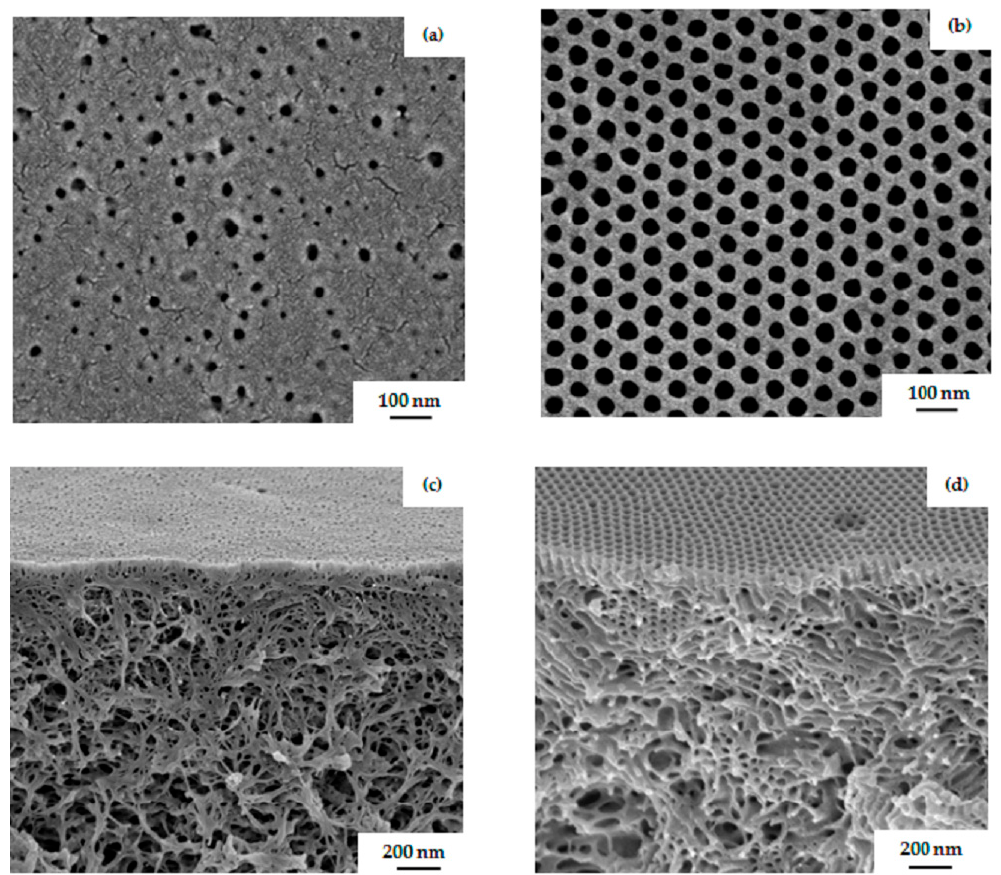
Figure 9. SEM topography images of membranes prepared from ( a ) 23 wt % PS 76 -PSMA 24135 and ( b ) 23 wt % PS 81 -PGMA 19128 in THF/DMF 50/50 wt %. The corresponding cross-section views for each case are shown in ( c ) and ( d ) images, respectively. The time of evaporation was 10